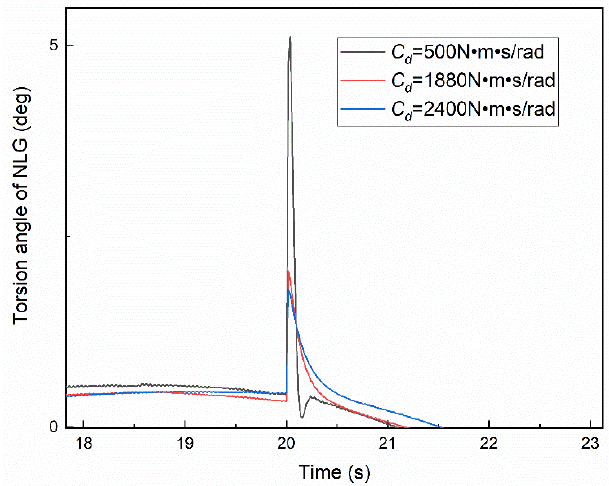
Figure 7. Effect of torsional damping on torsion angle of NLG.